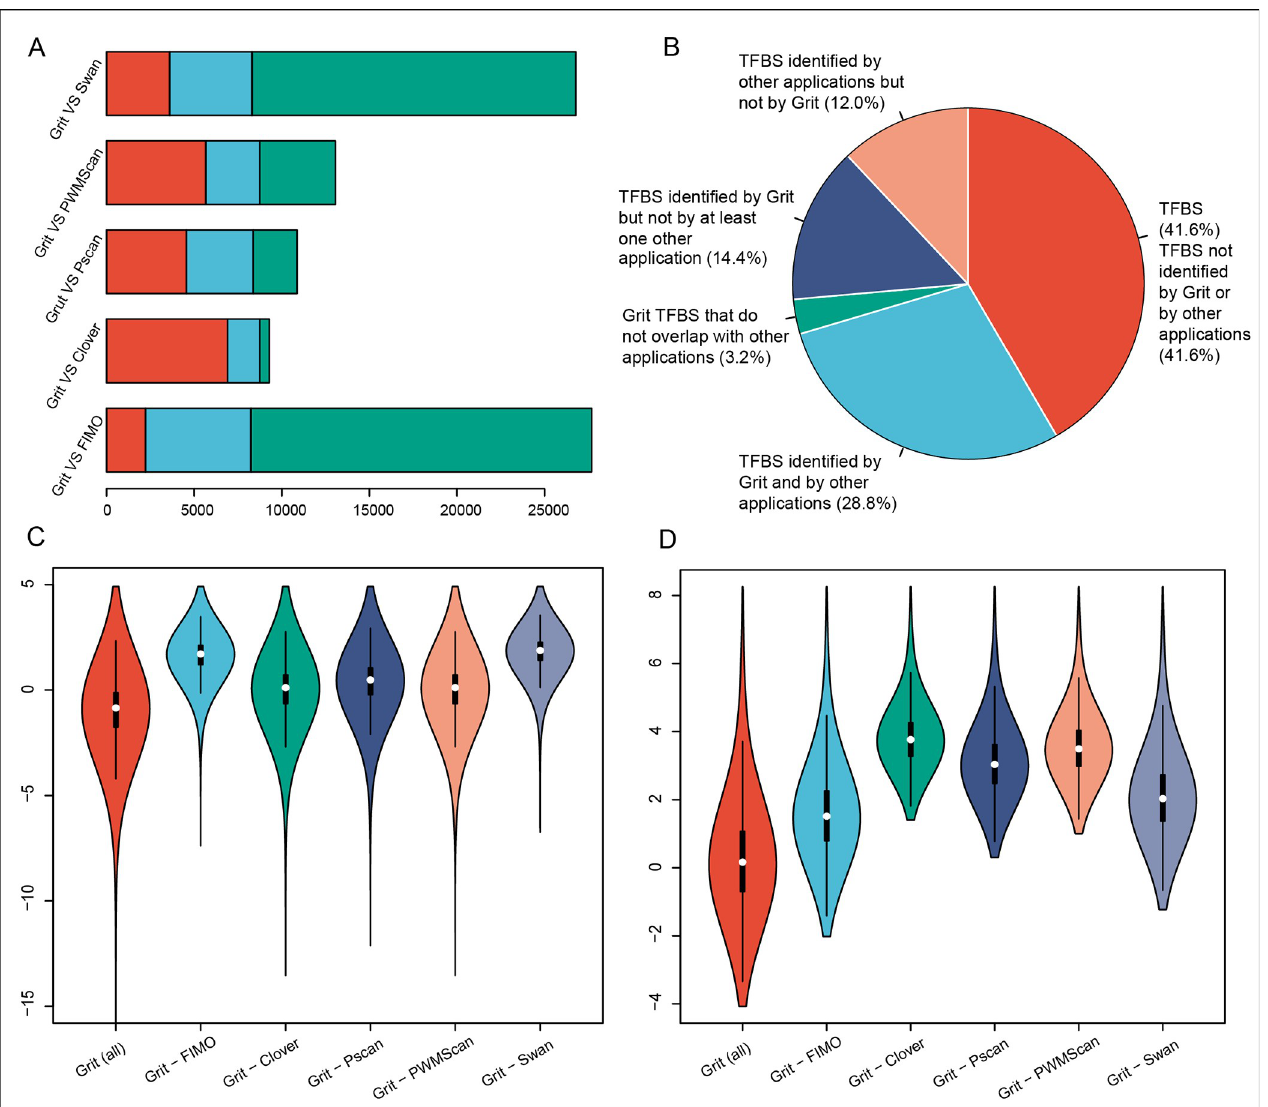
Fig 3. Differences among the results of Grit and other prediction tools. A. Number of transcription factor binding sites (TFBS) that overlap (light green) between Grit and other prediction tools, and Grit specific (red) or other tool specific (light blue) TFBS. B. Overall comparison of numbers of TFBS between prediction results of Grit and other prediction tools. The violin plot in C and D shown distributions of conserved variation ( CCV ) and standard difference ( SD ) for TFBS identified by Grit but did not by other tools (Grit–other, the symbol “–” means subtracting), respectively.